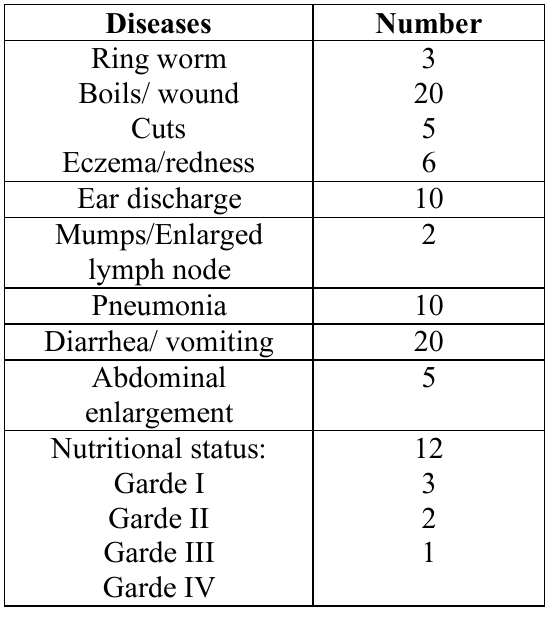
Table 3: Health Status of the Children